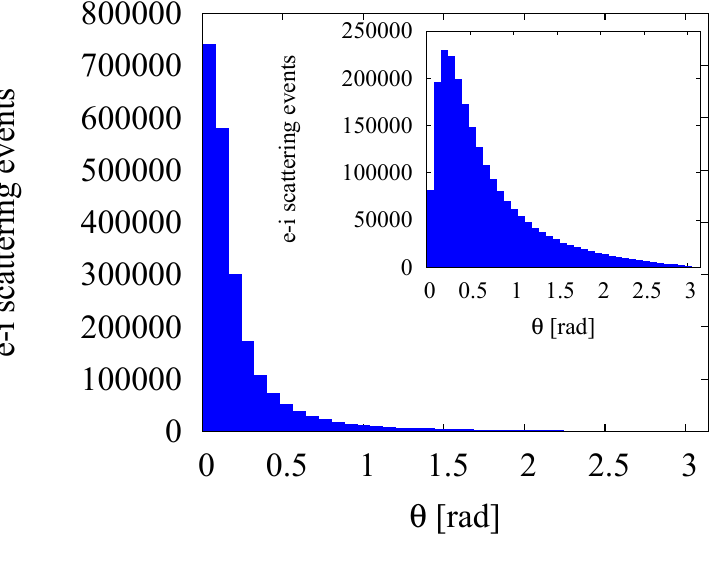
Figure 2. Histogram of the number of the electron-impurity scattering events against the scattering angle, θ . The simulation includes 5000 particles at T = 300 K. Electron-electron scattering is included in the simulation. The electron densities are n = 2 . 5 × 10 17 cm − 3 ( inset ). Note the different scales on the y panel ), and n e